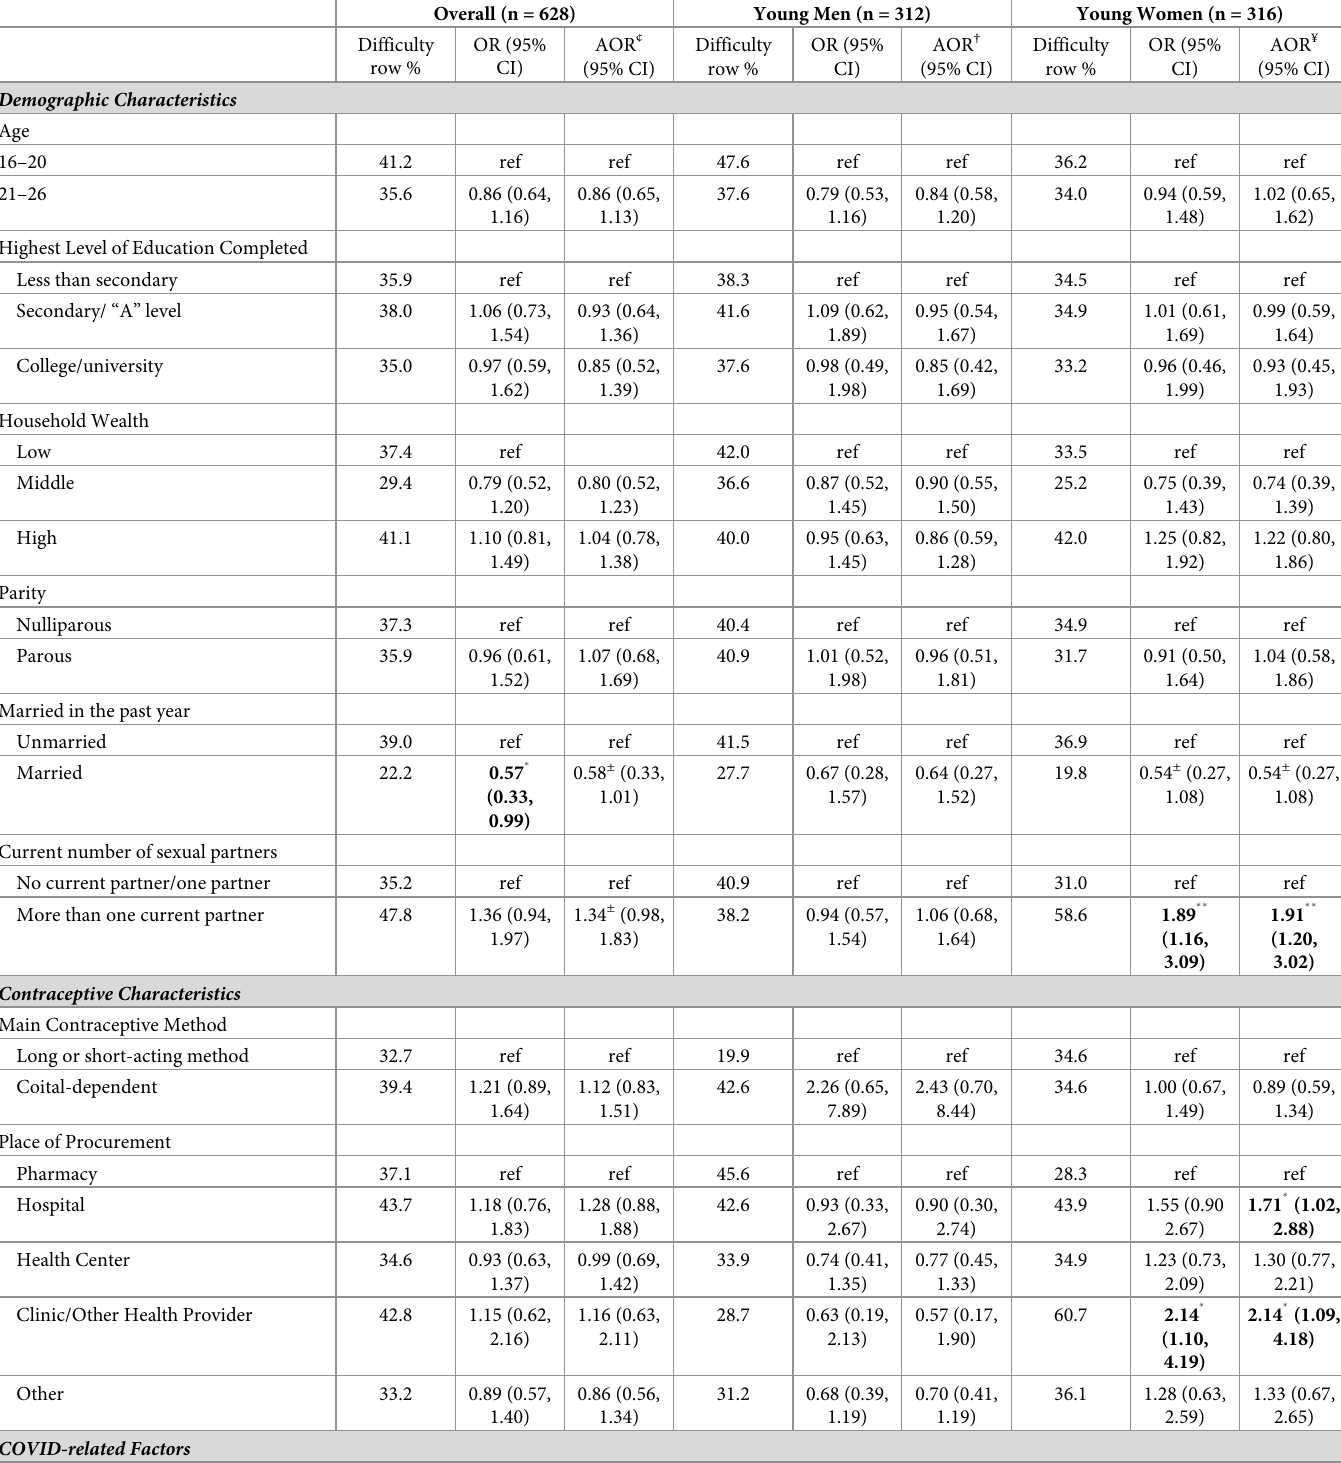
Table 2. Logistic regression examining any difficulty accessing contraception during COVID-19, among contraceptive users at follow-up, by gender, weighted (n =